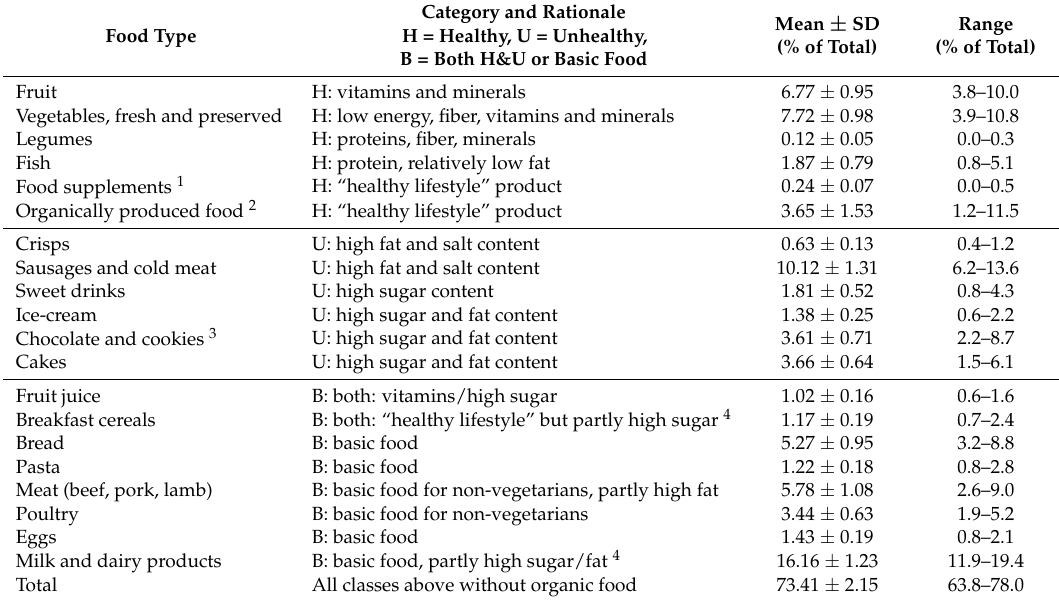
Table 2. Food types included in our analysis including their assignment to three categories of nutritional value and the distribution of their sales percentage (annual sales volume as % of total sales per store) among the 445